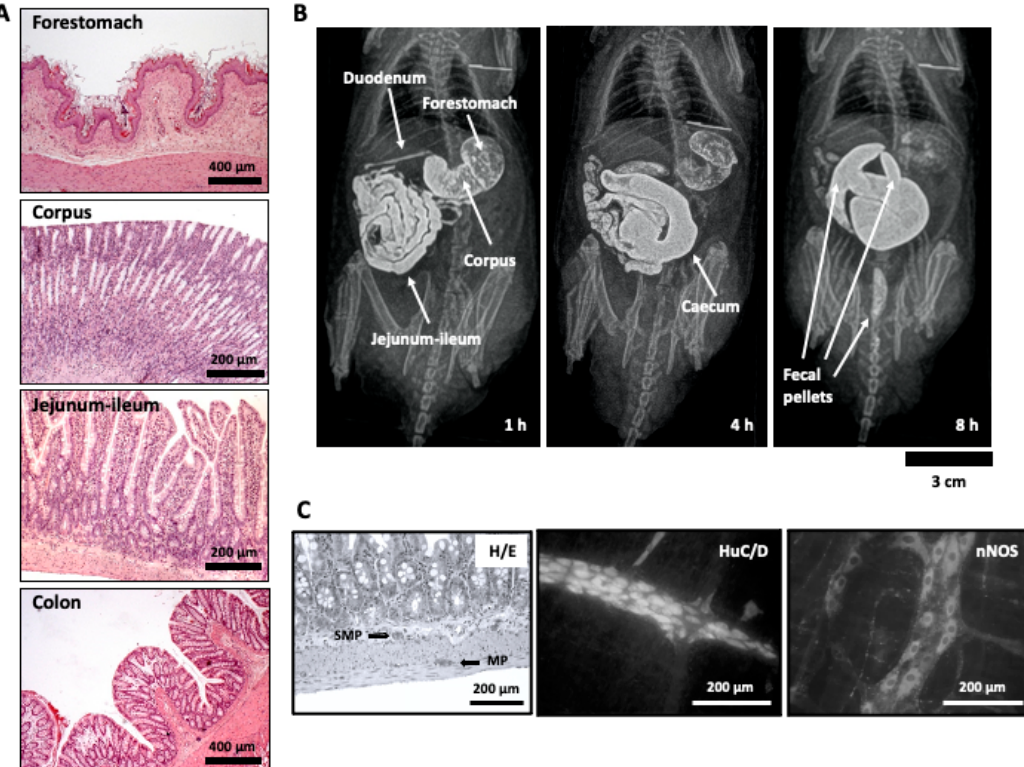
Figure 1. ( A ) Histological appearance of the wall of forestomach, corpus, jejunum-ileum (the longest part of the small intestine), and colon. ( B ) Organs of the rat gastrointestinal tract visualized by radiographic methods at different time points after intragastric barium administration in a conscious rat. Since rats do not vomit, barium can only progress towards the anus: 1 h after contrast, the two parts of the rat stomach (forestomach and corpus) can be distinguished, as well as the duodenum and the jejunum-ileum; 4 h after contrast, the stomach and small intestine can still be partially seen but now the cecum is filled with contrast; 8 h after contrast, the stomach and small intestine are barely seen, but the cecum is well filled with contrast and some fecal pellets are present within the colon. ( C ) Microscopic images showing the appearance of the enteric nervous system: left, location of the submucous (SMP) and the myenteric plexuses (MP) within the rat ileal wall in histological sections, stained with hematoxylin/eosin (H/E); middle and right, whole-mount or “sheet-like” preparations (from guinea pig ileum), obtained after dissecting away mucosa, submucosa, and circular muscle, leaving behind only the longitudinal muscle layer with the myenteric plexus attached; whole-mount preparations were processed immunohistochemically to show all the neurons with the pan-neuronal marker HuC/D (middle), or the specific subpopulation of neurons immunoreactive to neuronal nitric oxide synthase (nNOS), for which both somata and nerve fibers, but not nuclei, can be distinguished (right).